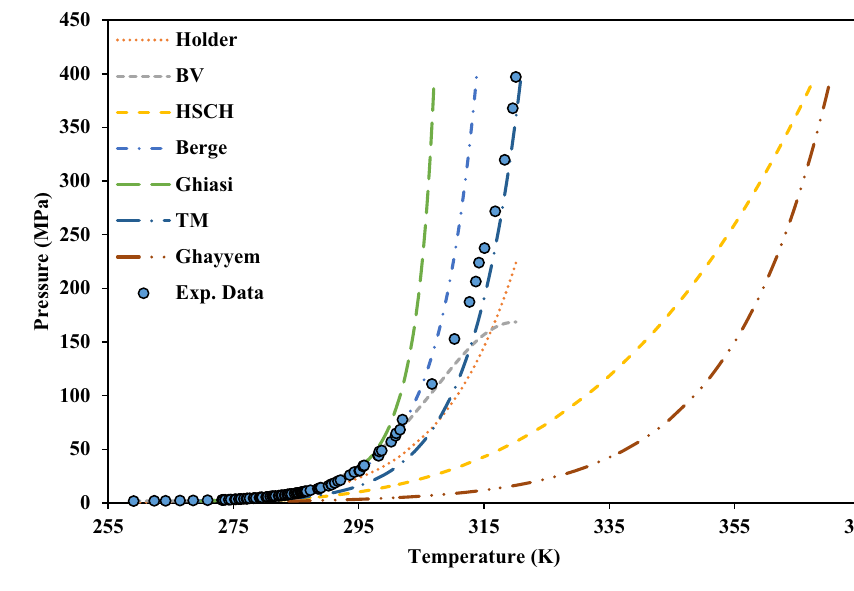
Fig. 6 Comparison between empirical correlations